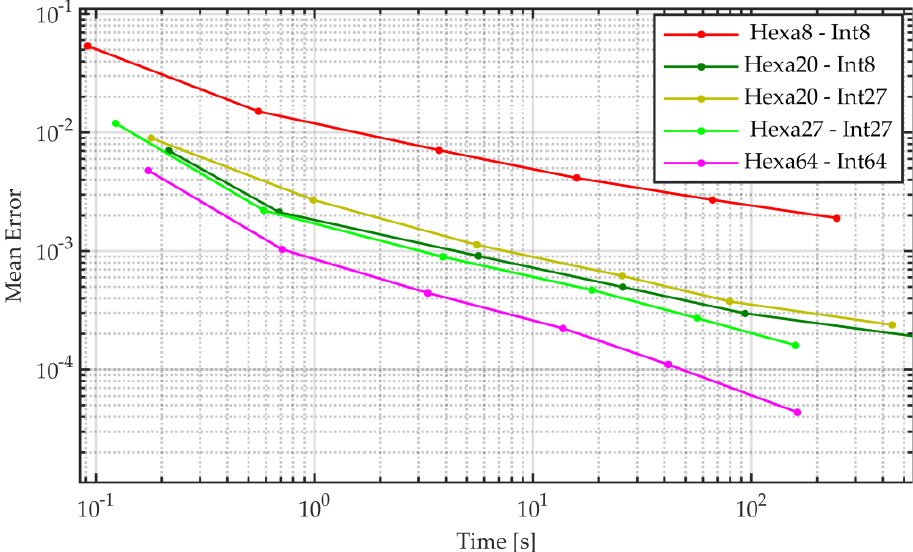
Figure 10. Convergence analysis of quadratic serendipity FE formulations as a function of the time for eigenvalue computation in comparison with full − order elements.